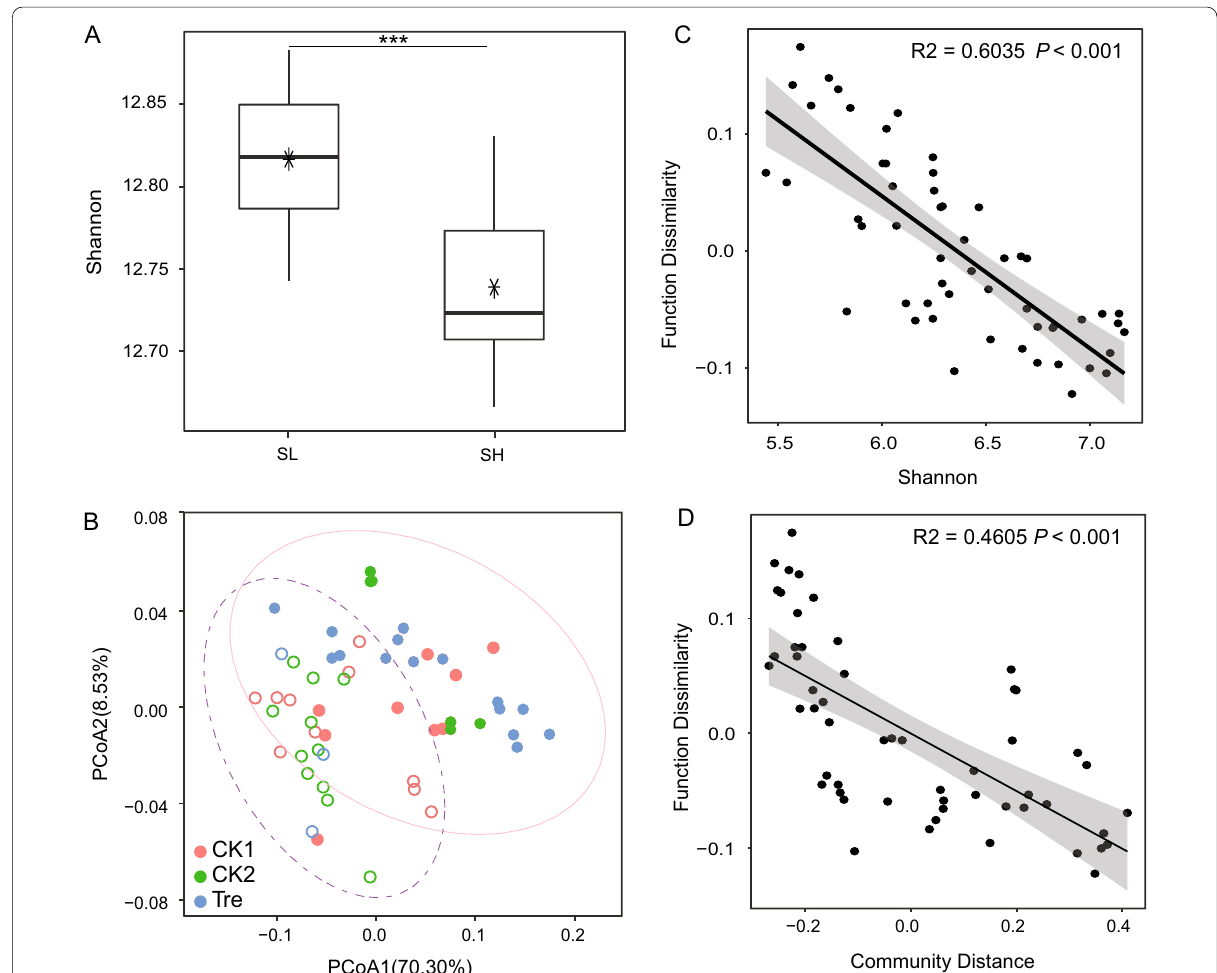
Fig. 4 Diversity of predicted function (Kos) in gut microbiome. A Alpha diversity (Shannon) of predicted function in gut microbiota (* P < 0.05; ** P < 0.01; Mann–Whitney U test). B Principal coordinates analysis plots of predicted function Bray–Curtis beta diversity for treatment and survival ratio (SR). The dotted ellipse border for SL and the solid ellipse border for SH both represent the 95% confidence interval. The hollow circle represents shrimp survival ratios of 70% (SL), while the solid circle represents shrimp survival ratios of > 70% (SH). C Relationships between function ≤ dissimilarity and Shannon in gut microbiota. D Relationships between function dissimilarity and community distance in gut